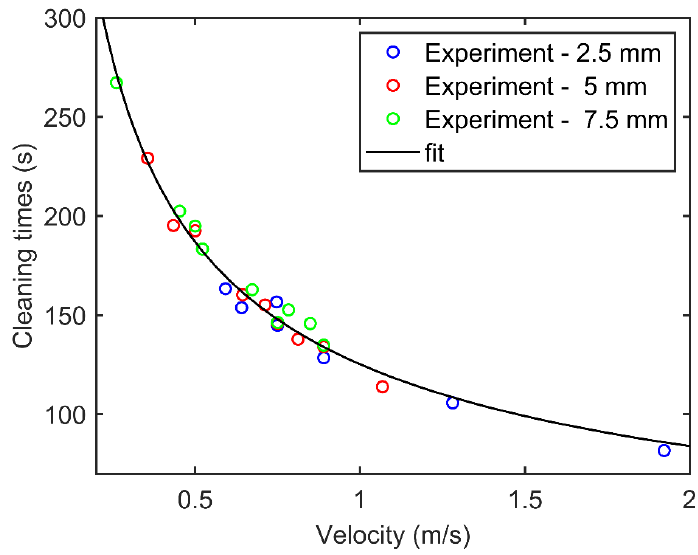
Figure 10. Cleaning times plotted against velocity.